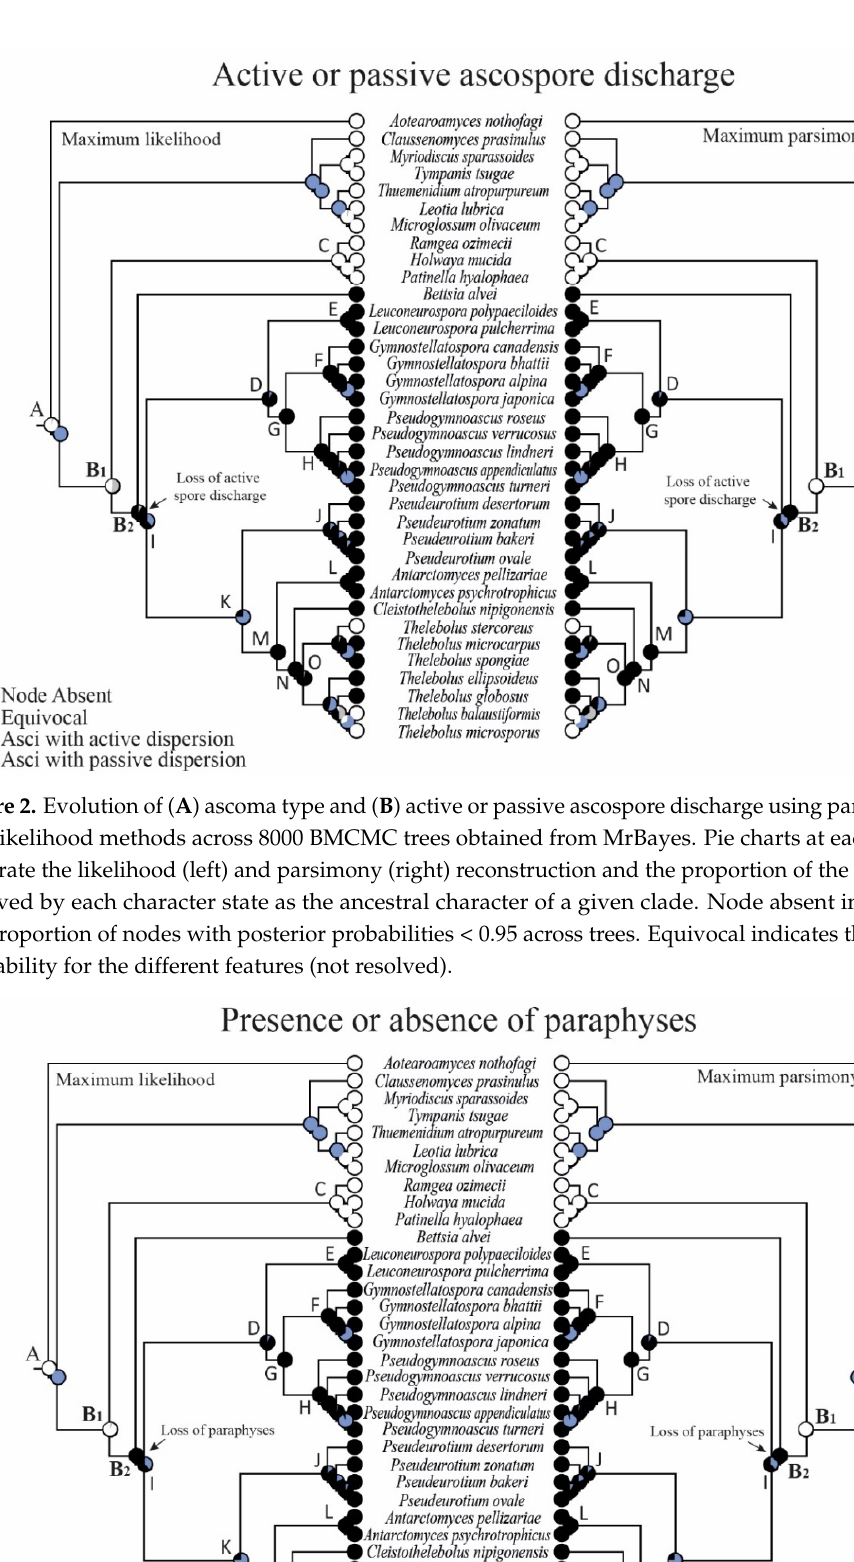
Figure 3. Evolution of ( A ) paraphyses and ( B ) ascospore morphology using parsimony and likeli- hood methods across 8000 BMCMC trees obtained from MrBayes. Pie charts at each node illustrate the likelihood (left) and parsimony (right) reconstruction and the proportion of the average received by each character state as the ancestral character of a given clade. Node absent indicates the propor- tion of nodes with posterior probabilities < 0.95 across trees. Equivocal indicates the same probabil- ity for the different features (not resolved).